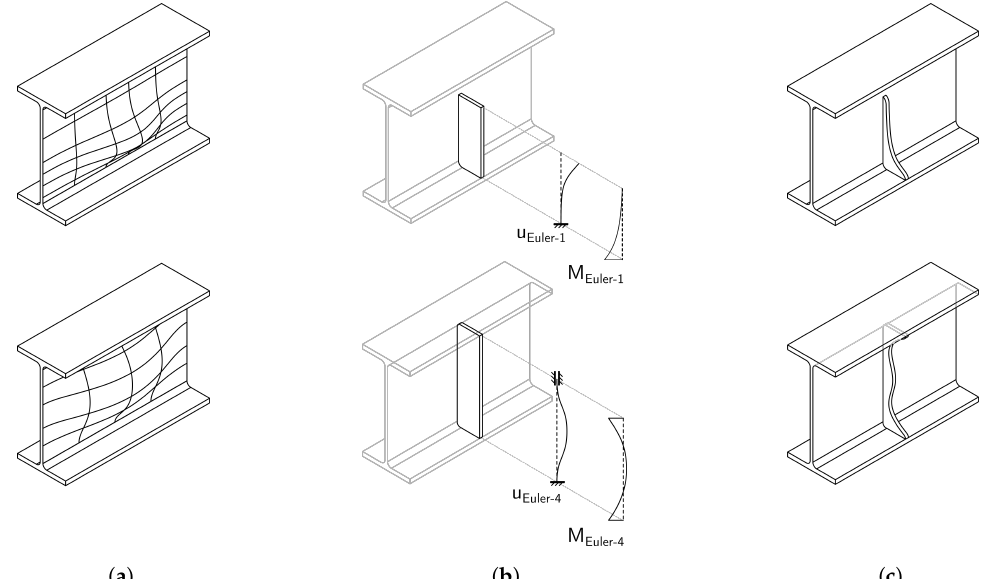
Figure 8. Design approach—material reduction: ( a ) underlying failure mode; ( b ) static system of the stiffener; ( c ) derived new stiffener